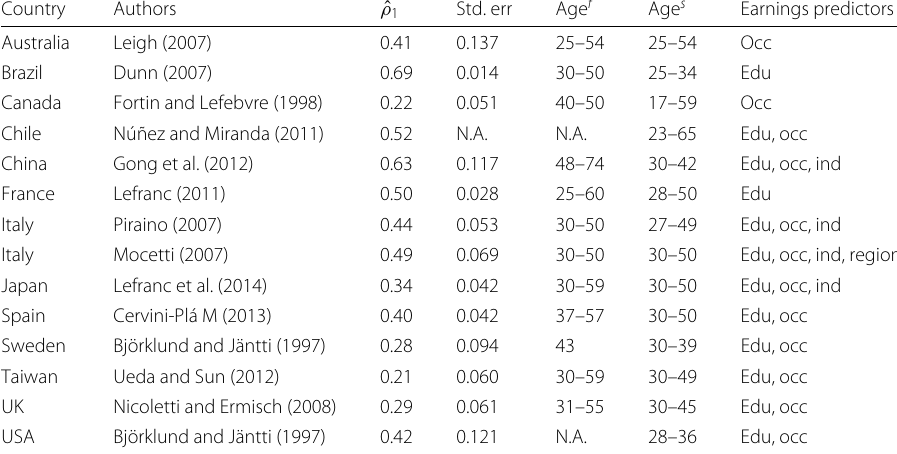
Table 5 Comparable intergenerational earnings elasticity with two-sample estimation